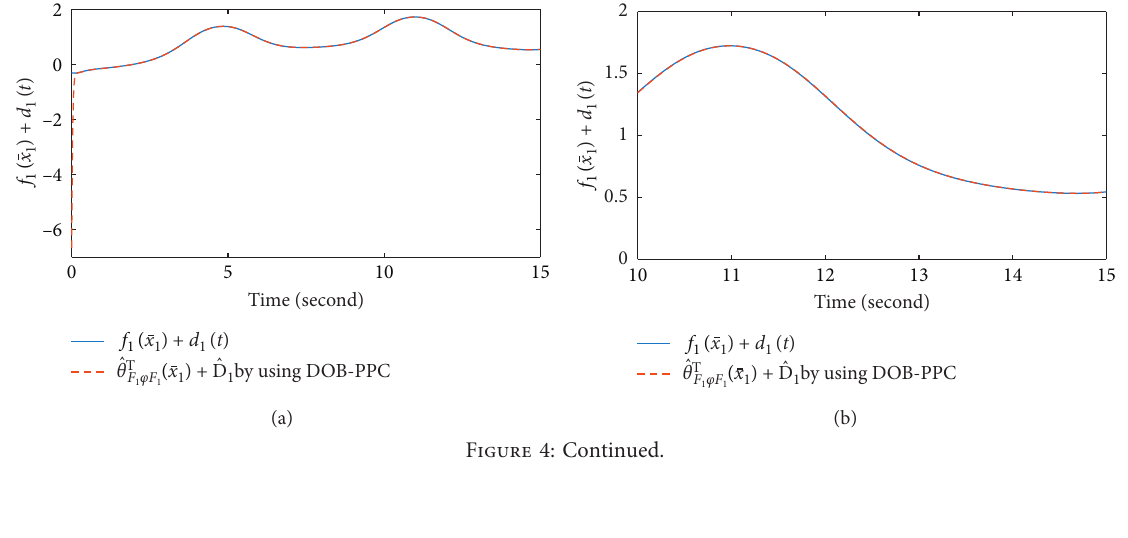
Figure 3: Estimation of f PPC in time period (c) [0, 15s]; (d) [10 s, 15